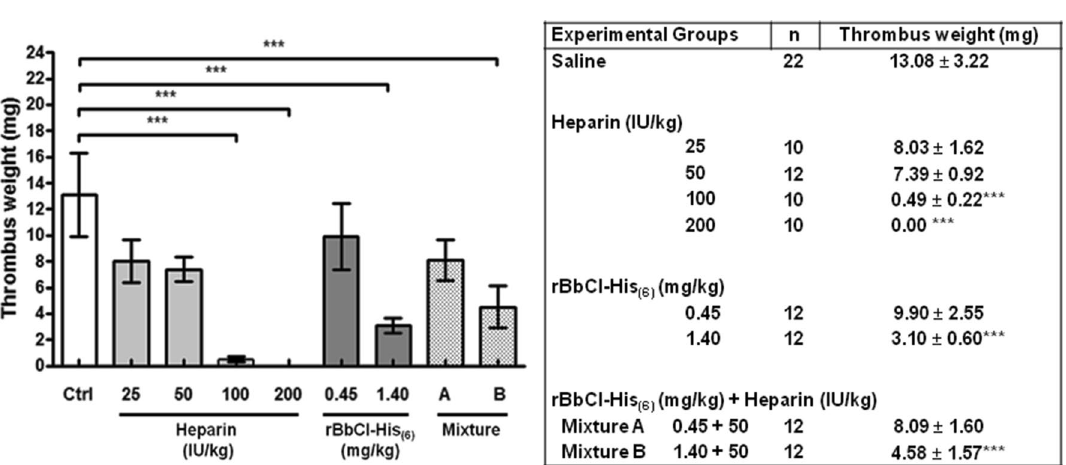
Figure 4. Effect of heparin, rBbCI-His (6) , and heparin plus rBbCI-His (6) on thrombus weight. Rats were treated intravenously with saline (control), heparin, inhibitors, or heparin plus rBbCI-His (6) for 30 min before VC ligature. The thrombus was removed and weighted 4 h after the ligature (“ex-vivo” group). Values are expressed as mean ± s.d.. * p ˂ 0.05, ** p ˂ 0.01, and *** p ˂ 0.001 versus the corresponding values in the saline